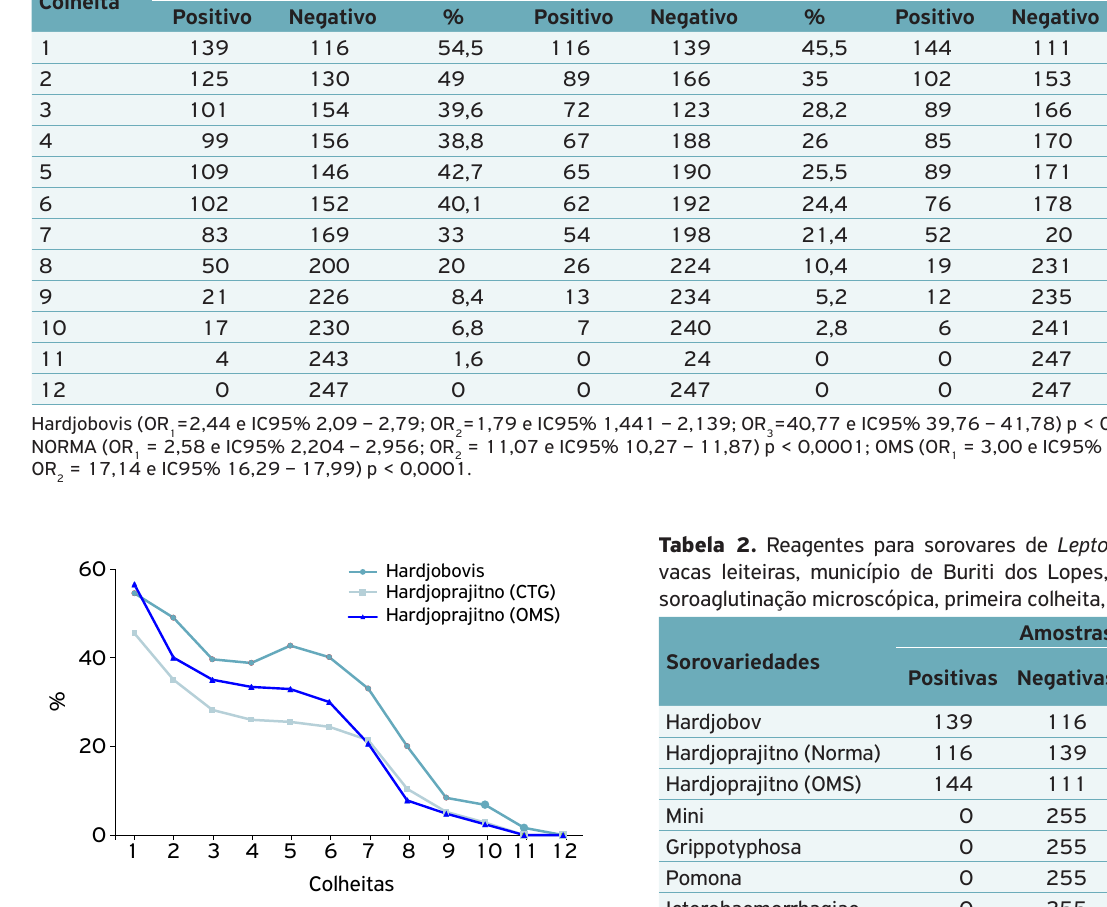
Figura 1. Positividade para diferentes sorovariedades